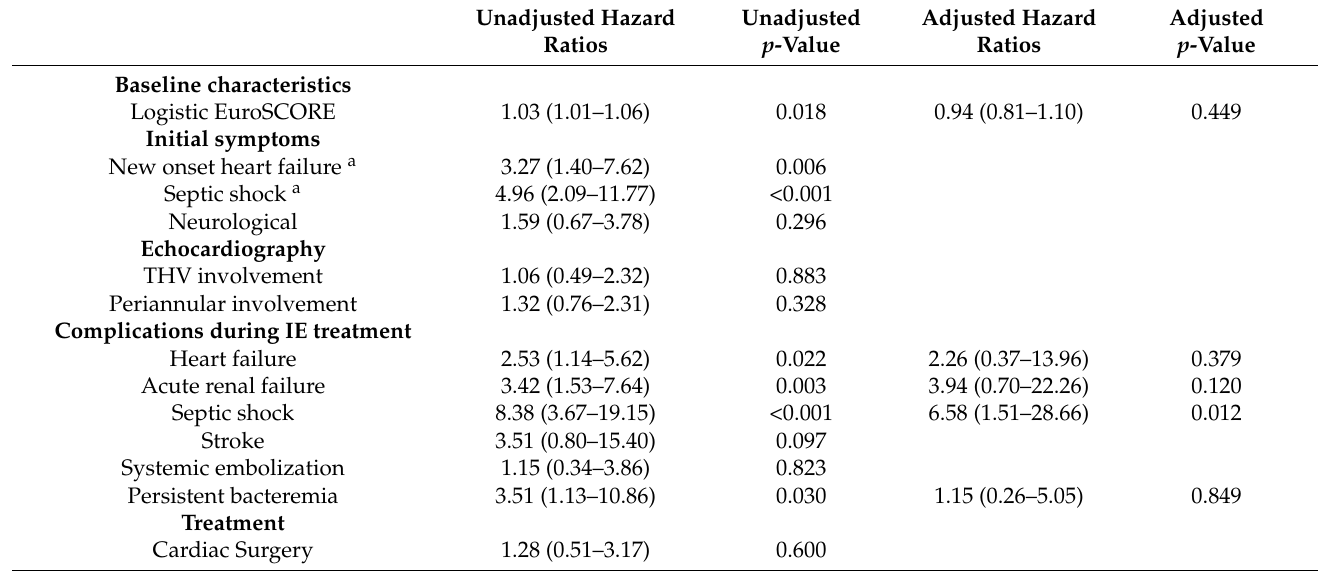
THV indicates transcatheter heart valve; IE, infective endocarditis. a excluded to avoid